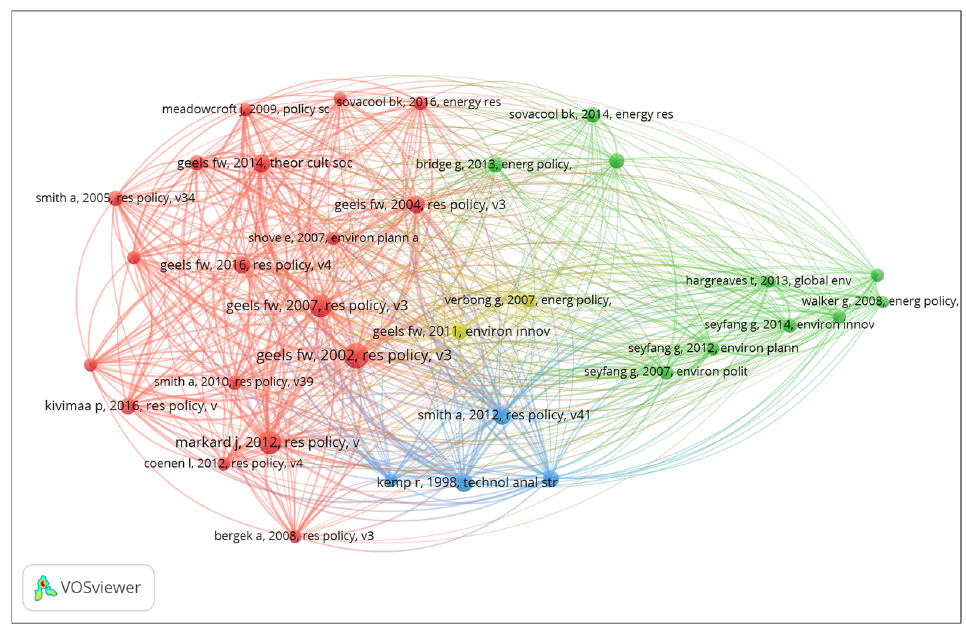
Figure 3. VOSviewer diagram containing the most cited papers with at least 25 citations (top 500), for the couple: social innovation–energy transition .